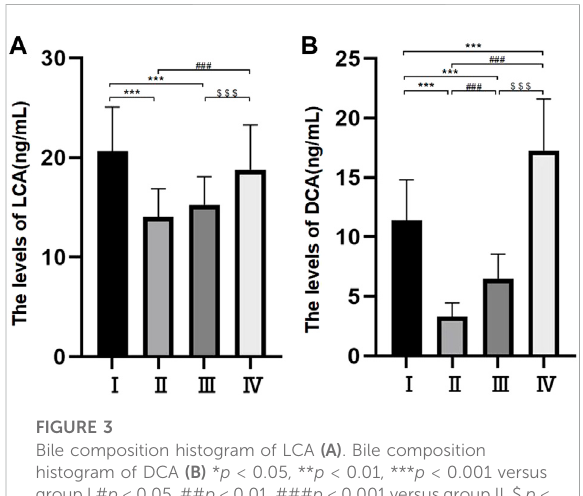
FIGURE 3 Bile composition histogram of LCA (A) . Bile composition histogram of DCA (B) * p < 0.05, ** p < 0.01, *** p < 0.001 versus group I # p < 0.05, ## p < 0.01, ### p < 0.001 versus group II. $ p